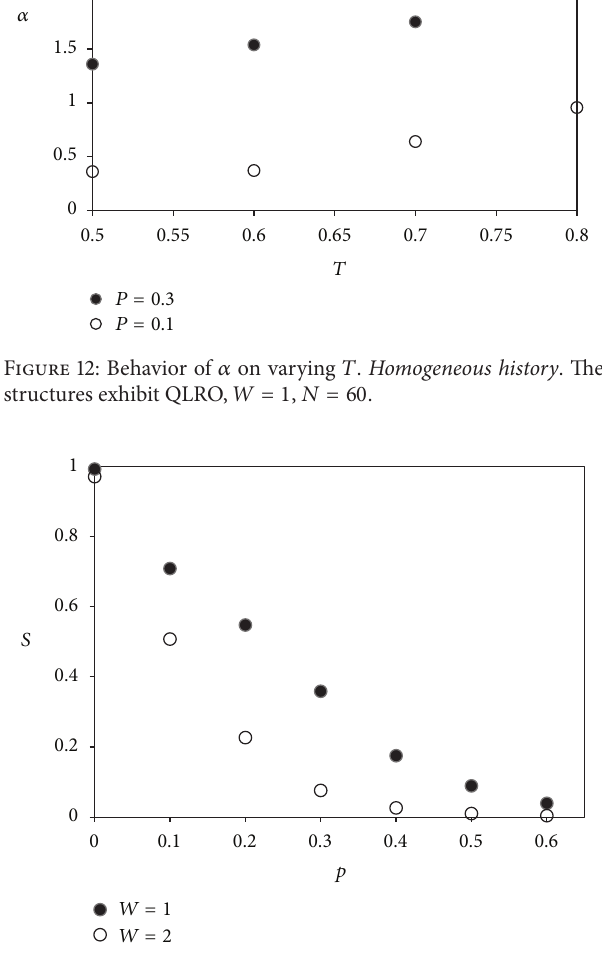
Figure 13: 𝑆(𝑝) dependence is shown for different anchoring strengths. Homogeneous history , 𝑁 = 60 , 𝑇 = 0.1